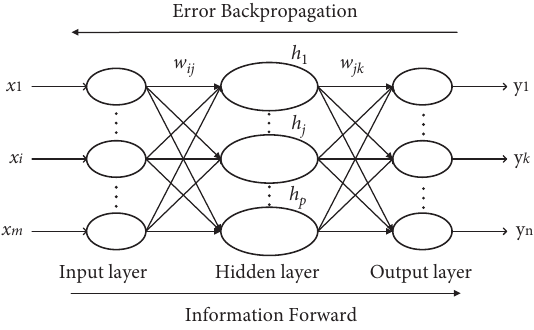
Figure 3: BP neural network.